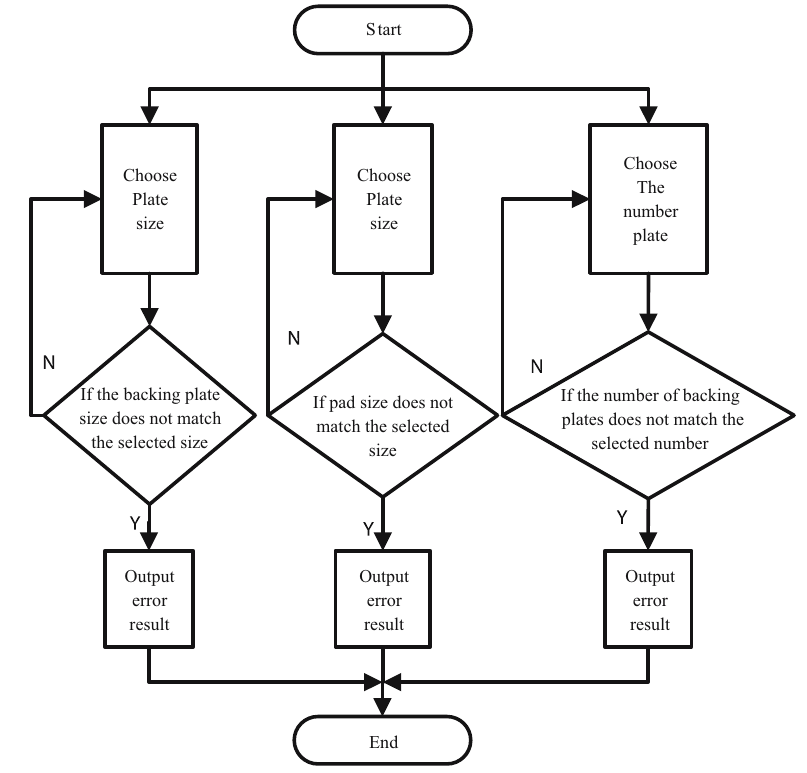
Figure 4: Identi fi cation process of base plate